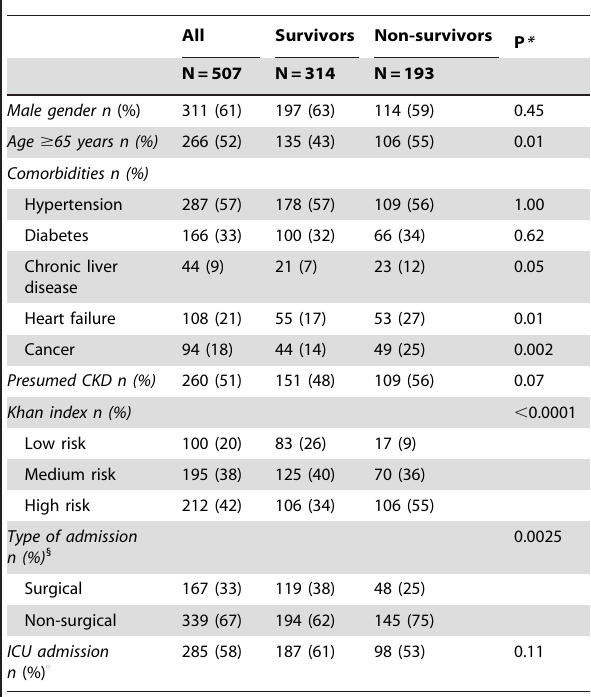
Table 1. Characteristics of the included patients. Table 2. Characteristics of the acute kidney injury episode.